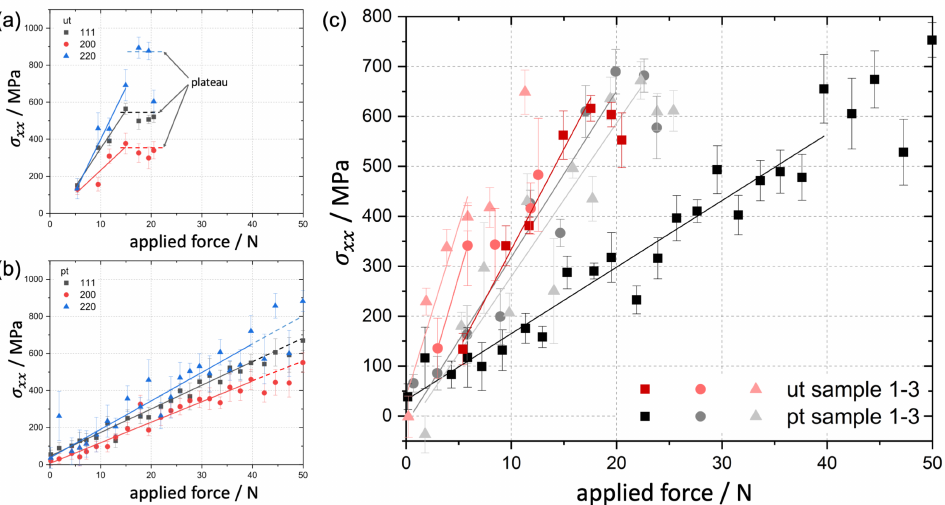
Figure 8. Measured in-plane stress perpendicular to the bending axis σ xx at the interface in Ni for different lattice planes for ( a ) an untreated (ut) and ( b ) a pre-treated (pt) specimen: the untreated specimens show a higher scattering of the data and a lower strength compared to the pre-treated ones. The data for the 6 investigated struts were gathered by full immersion of the beam to the Ni/Al interface ( c